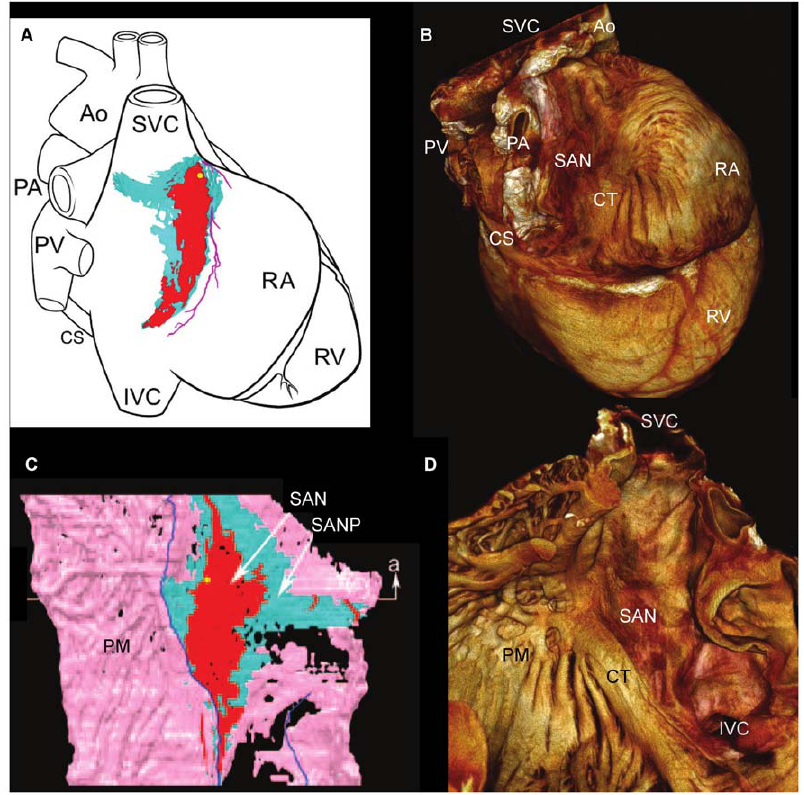
Figure 4. Identification of the sino atrial node. Transverse micro-CT image of the free wall of the right atrium showing the sino atrial node (A) in a rabbit heart stained with 7.5% I 2 KI for 3 days, with 3D rendering of the heart showing the associated plane of interest. Corresponding volume rendering (B) and Segmented 3D surface (C). Distance between red dots- 4.9 mm, blue dots- 2.5 mm. CT- crista terminalis, IVC- inferior vena cava, PM- pectinate muscle, RA- right atrium, SAN- sinoatrial node, SNA- sinus node artery, SVC- superior vena cava. (Scale bar represents 1